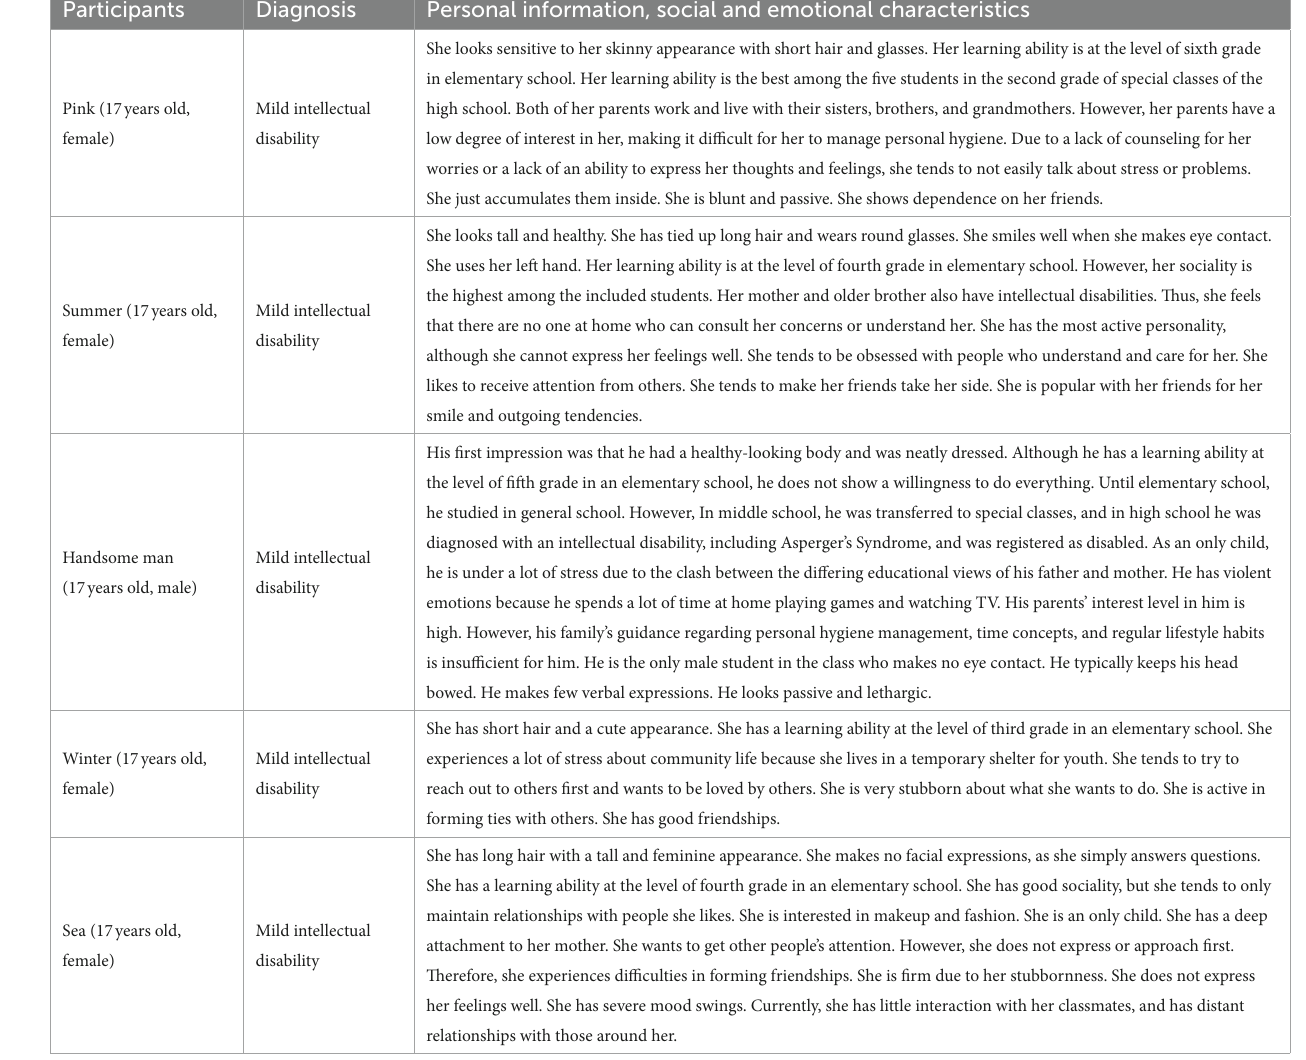
TABLE 1 Personal information as well as social and emotional characteristics of research participants. Participants Diagnosis Personal information, social and emotional